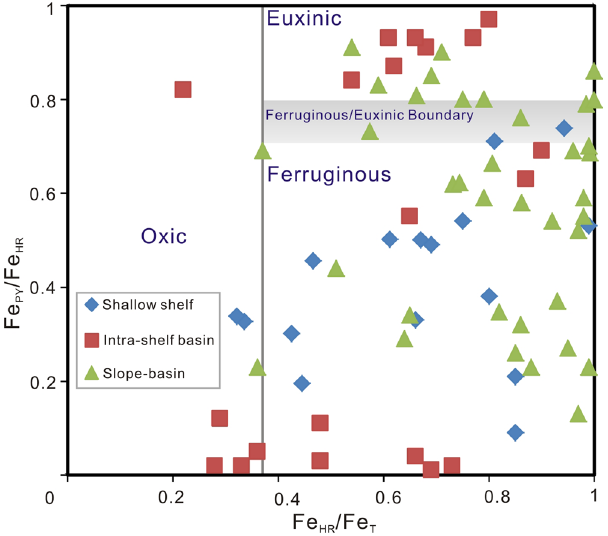
Figure 5. Fe speciation diagram for Cambrian samples from various depositional environments. Data are compiled from refs 14–16, 35 and